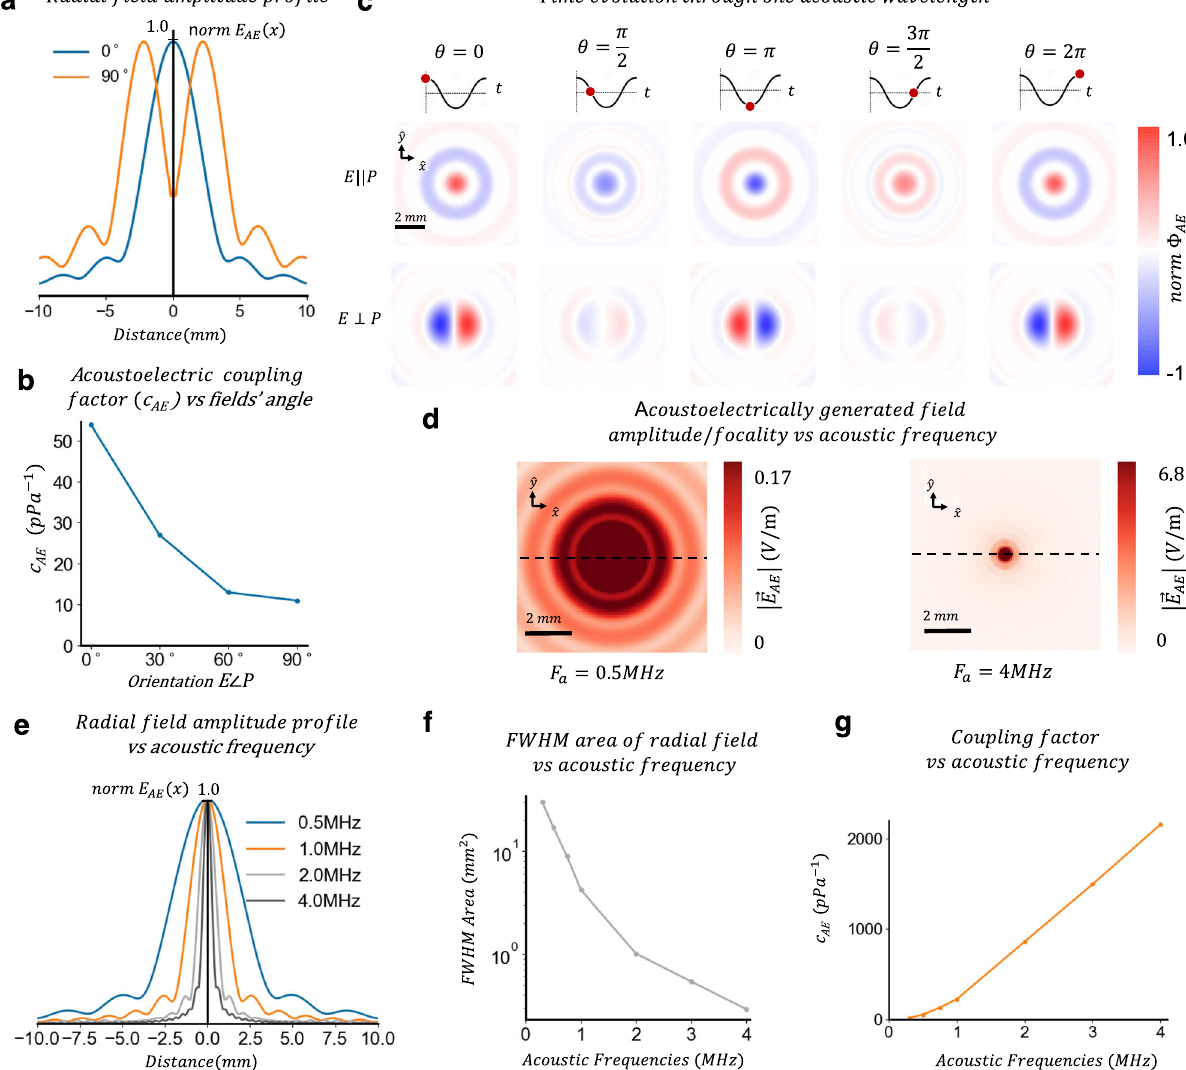
! j Fig. 2 Simulation predictions of the acoustoelectric effect in weak electrolytes. a Line plot comparing the normalized amplitude of generated fi eld j E ae along the black dashed lines in Fig. 1(b) and (e). b Acoustoelectric coupling factor c ae vs. angle between the applied electric fi eld and acoustic propagation direction. c Evolution of the generated electric fi eld over time shown at the same point in space (focus) as time progresses over an acoustic wavelength. Shown are Φ AE maps in the radial plane ^ x ^ y at different phases of the ultrasound transducer period for a parallel and perpendicular electric fi eld orientation; θ , instantaneous phase of the applied acoustic fi eld. d Effect of the applied acoustic fi eld frequency on the generated electric fi eld. Electric and acoustic ! fi elds were applied as in Fig. 1a but at different acoustic frequencies. Representative j E j maps in the radial plane ^ x ^ y with acoustic fi eld at f = 500 kHz ! A AE j along the ^ x direction vs. applied acoustic frequency. f Full-width half maximum (FWHM) area of the and f A = 4 MHz, respectively. e , Normalized j E AE generated fi eld vs. applied acoustic frequency decreases as frequency increases. g Acoustoelectric coupling factor vs. applied acoustic frequency increases as frequency